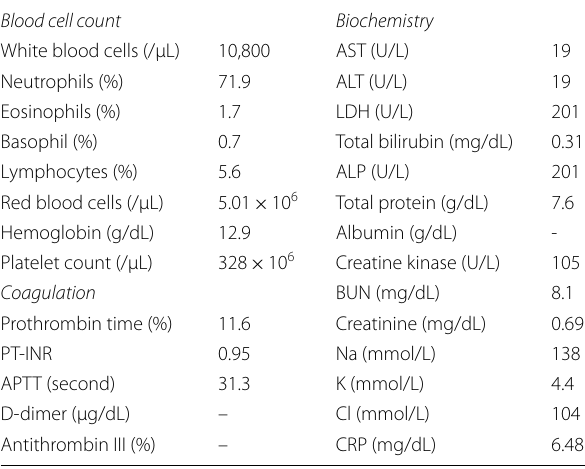
PT-INR international normalized ratio of prothrombin time, APTT activated partial thromboplastin time, AST aspartate aminotransferase, ALT alanine aminotransferase, LDH lactate dehydrogenase, ALP alkaline phosphatase, BUN blood urea nitrogen, CRP C-reactive